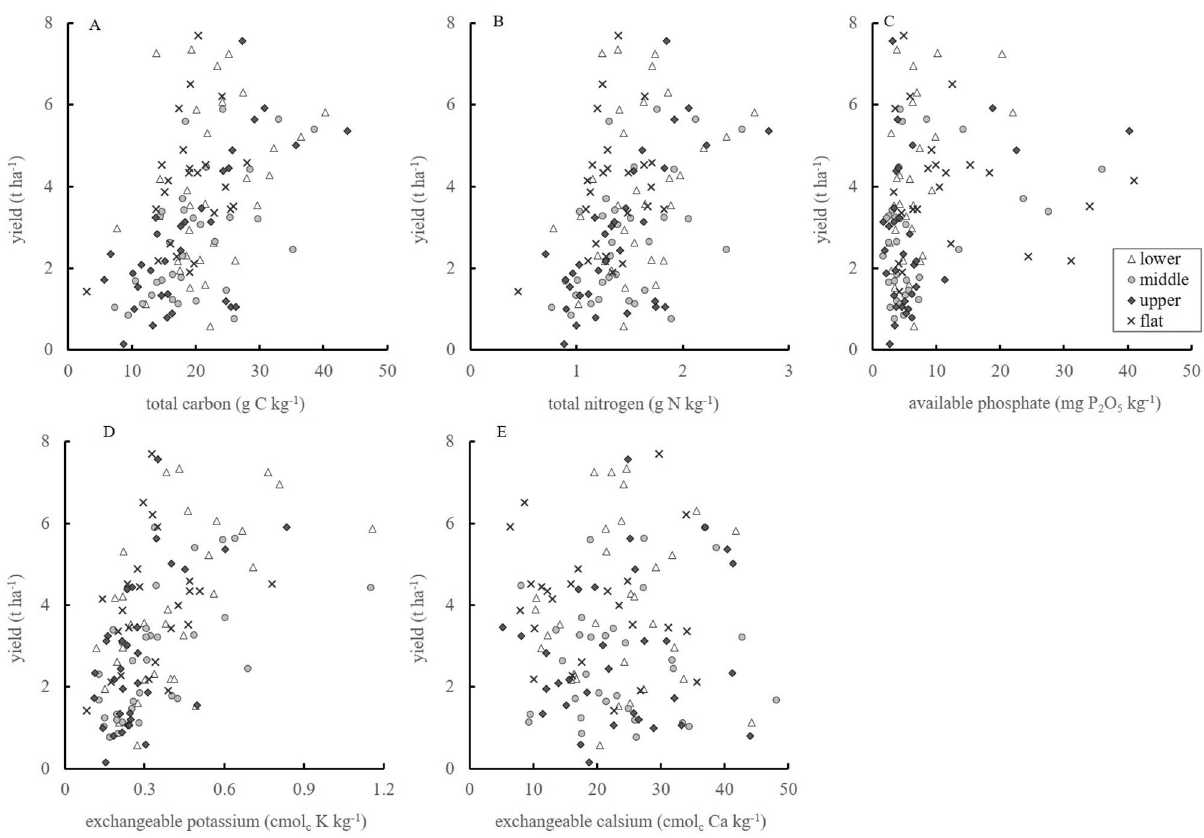
Figure 3. Relationships between the five soil nutrients and maize yield, A totale carbon (TC), B total nitrogen (TN), C exchangeable potassium (Ex-K), D available phosphate (Av-P), and E exchangeable calcium